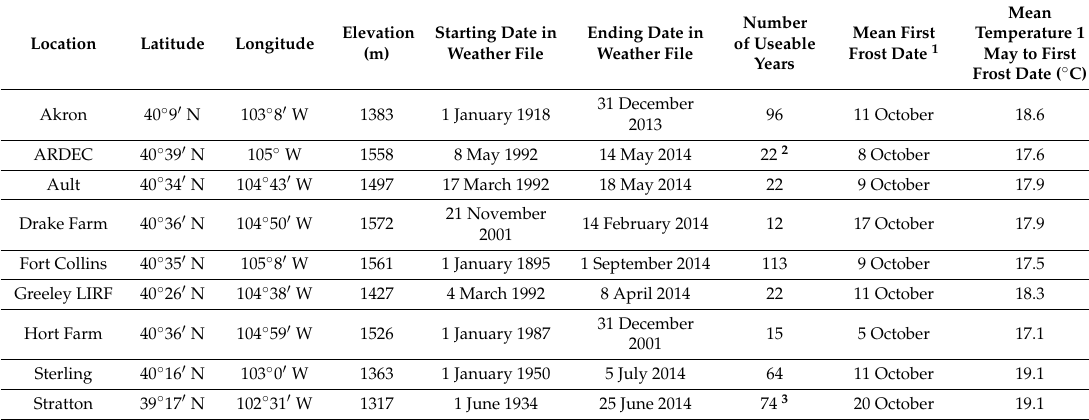
Table 1. General weather information for nine locations in northeastern